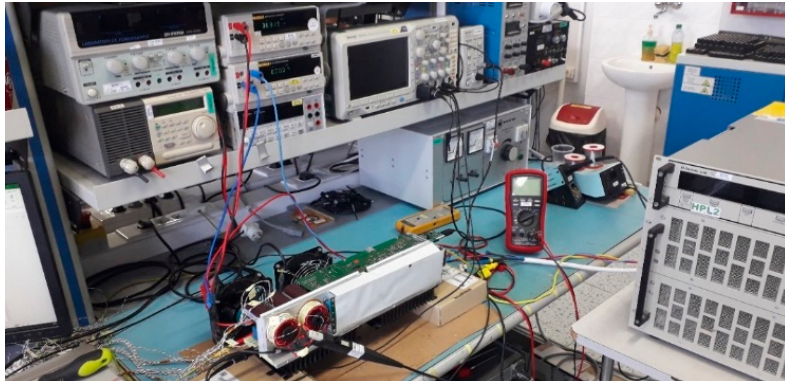
Figure 7. Experimental workplace for laboratory testing.